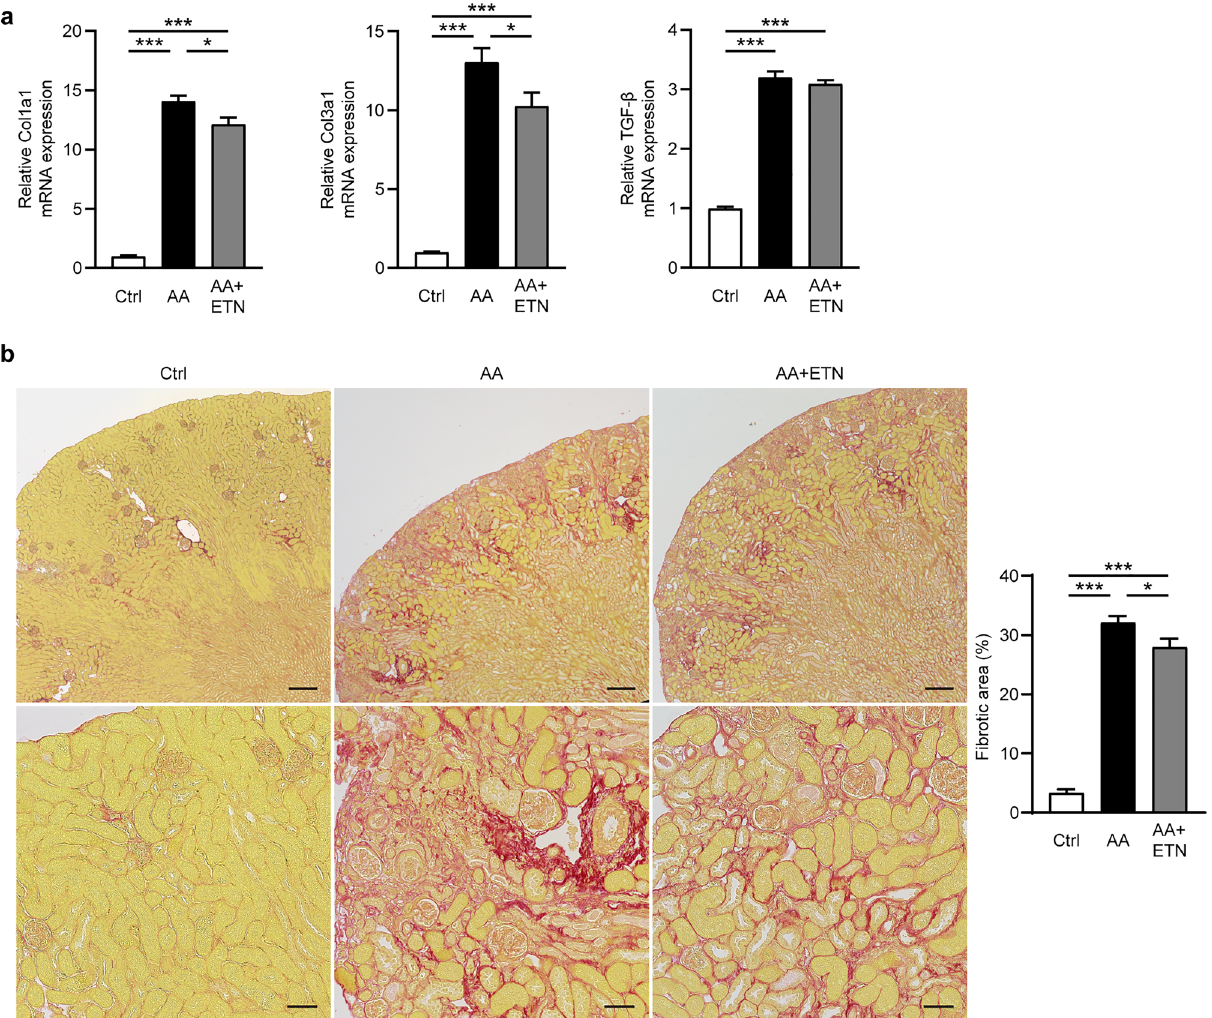
Figure 3. Effect of etanercept on kidney fibrosis. ( a ) Relative renal mRNA expression of Col1a1, Col3a1, and TGF-β ( n = 7–8). ( b ) Representative images of kidneys stained with picrosirius red (upper panel, original magnification, × 40, bar, 200 μm; lower panel, original magnification, × 200, bar, 50 μm), and quantitative analysis of kidney fibrotic area ( n = 7–8). Values are means ± SEM. * P < 0.05, *** P < 0.001. Ctrl, control; AA, aristolochic acid; ETN, etanercept; Col, collagen; TGF, transforming growth